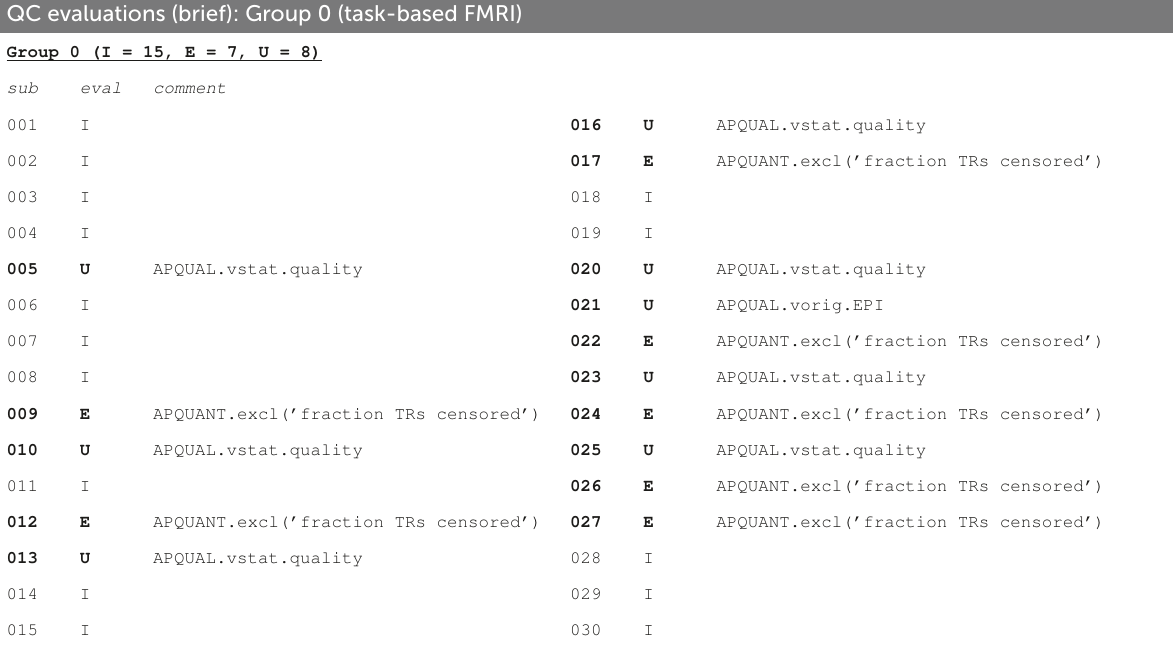
TABLE 5 A brief summary of task-based FMRI dataset evaluations, based on the APQUANT, APQUAL and GUI QC checks. QC evaluations (brief): Group 0 (task-based FMRI) Group 0 (I = 15, E = 7, U =